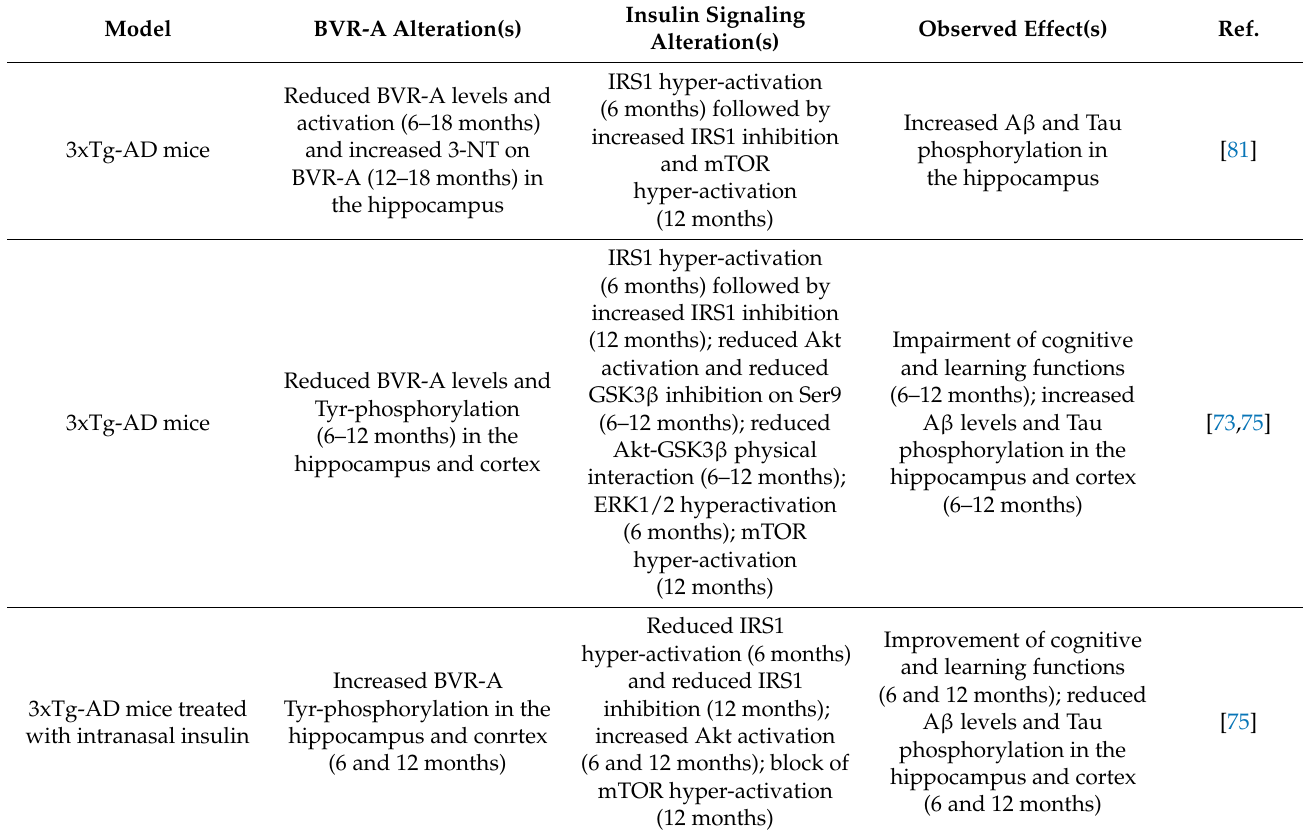
Table 2. Summary of the studies highlighting a link between BVR-A alterations and insulin signaling- related pathways in neurodegenerative